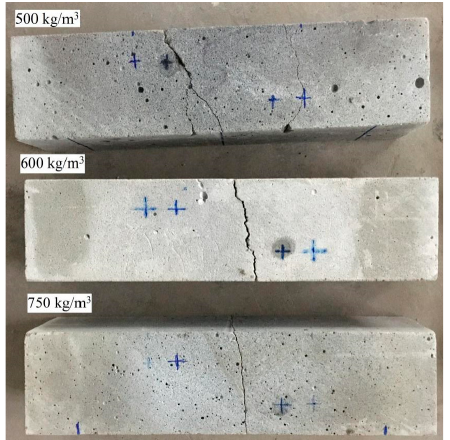
Figure 14. The failure mode of foamed concrete with different densities at a fixed loading rate.